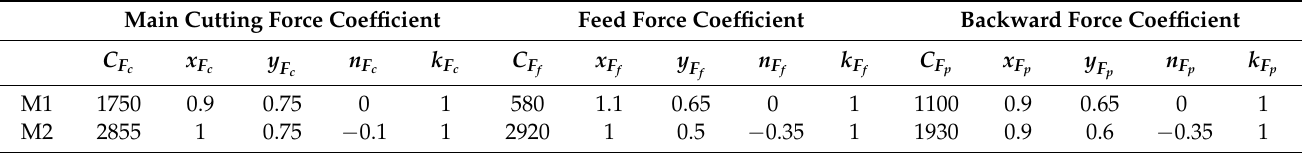
Table 3. Cutting force coefficient.